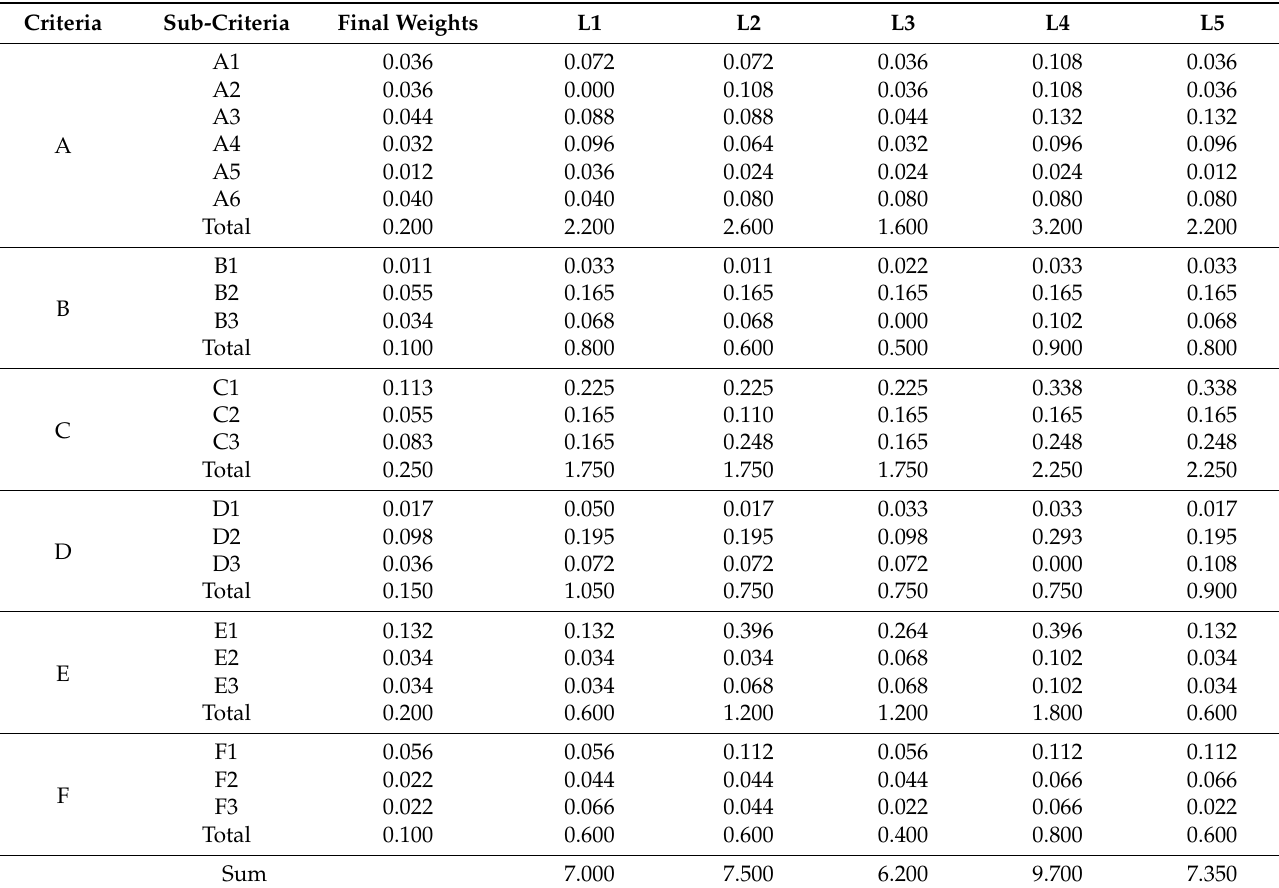
Table 6. List of the results of the variant assessment using the weight-score